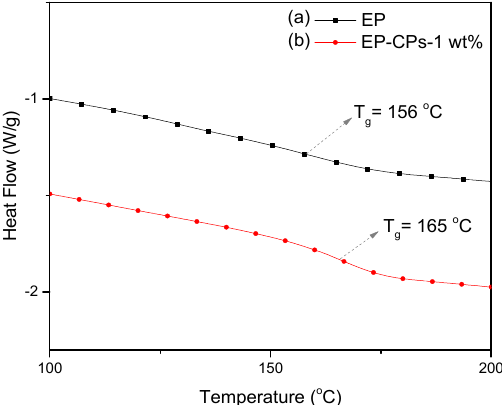
Figure 8. Differential scanning calorimetry (DSC) traces of ( a ) epoxy-amine network (EP) and ( b ) microcomposite containing 1 wt.% of SiO 2 @IL microcapsules (EP-CPs-1 wt.%) (heating: 10 K min − 1 ).